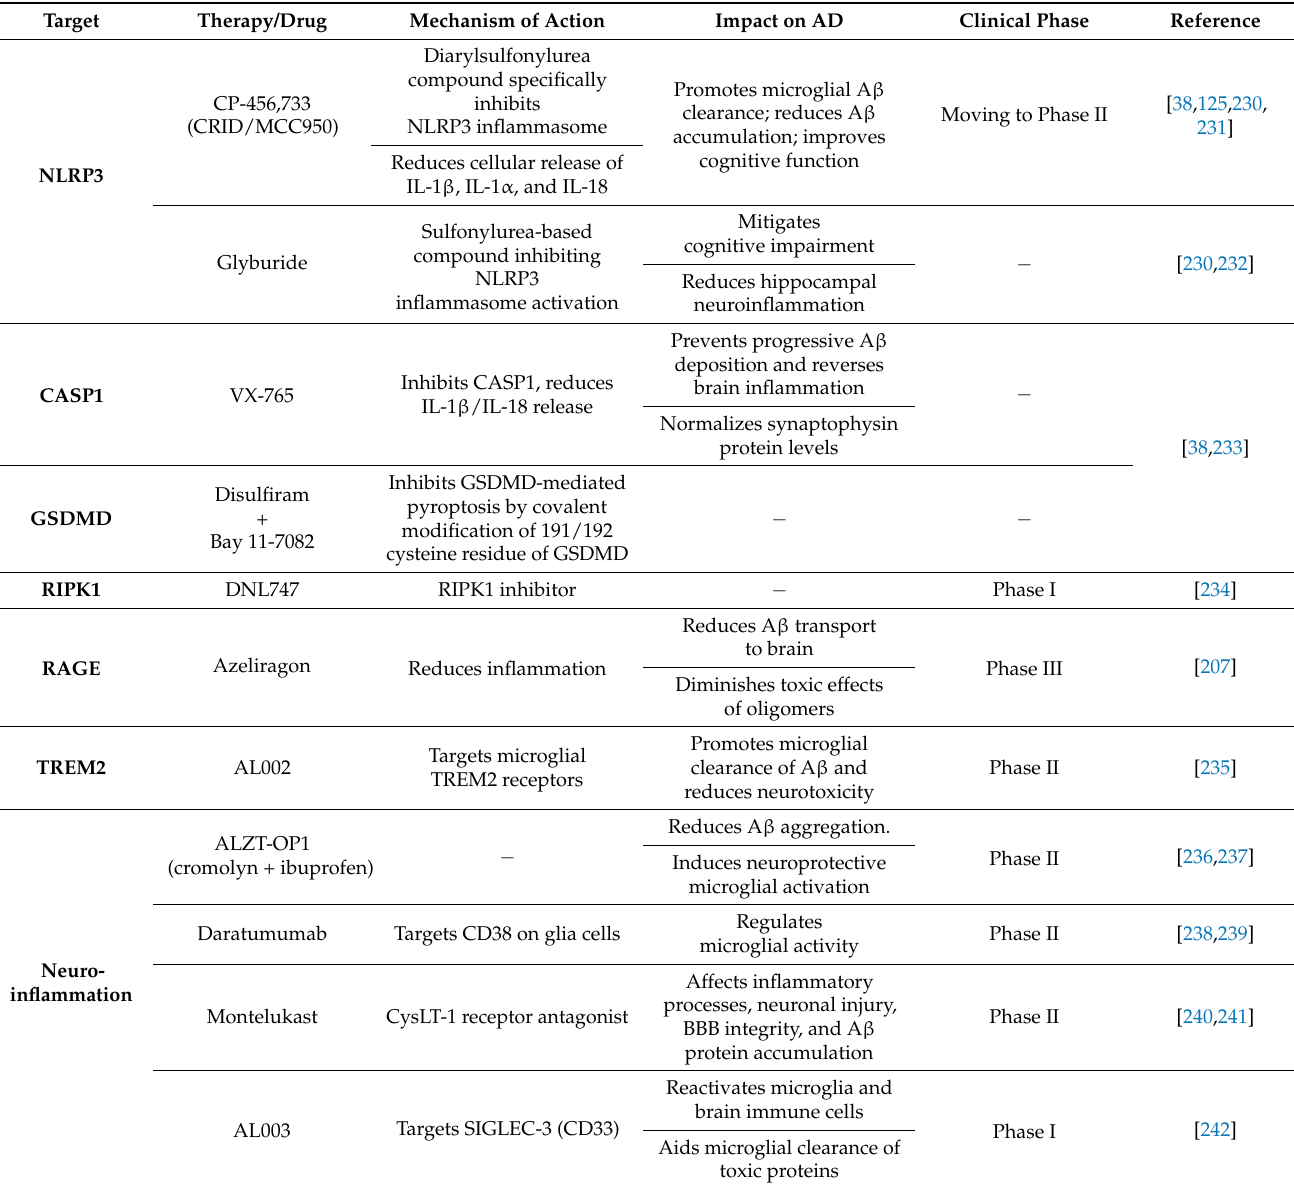
Therapeutic options targeting neuro-inflammation and cell death pathways in Alzheimer’s